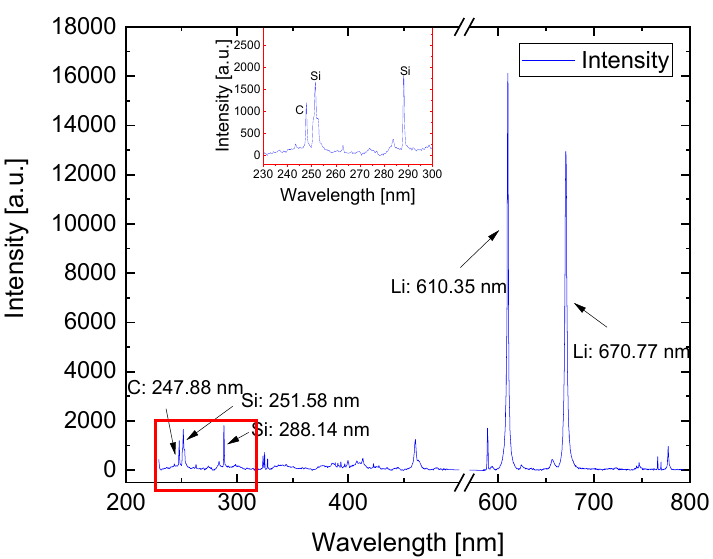
Figure 5. LIBS spectrum of a silicon–graphite electrode with the indication of the most relevant emission lines of lithium, graphite, and emission lines of lithium, graphite, and silicon.